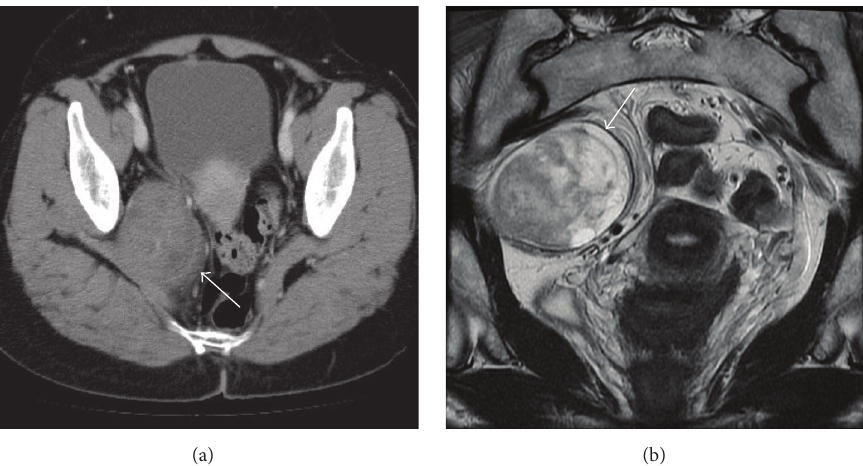
Figure 1: (a) Enhanced abdominal computed tomography revealing a 65 × 50mm, solid, well-defined, heterogeneous mass (arrow) in the right lateral pelvis space. (b) Magnetic resonance imaging revealing heterogeneous hyperintensity in the tumor (arrow) on T2-weighted image.